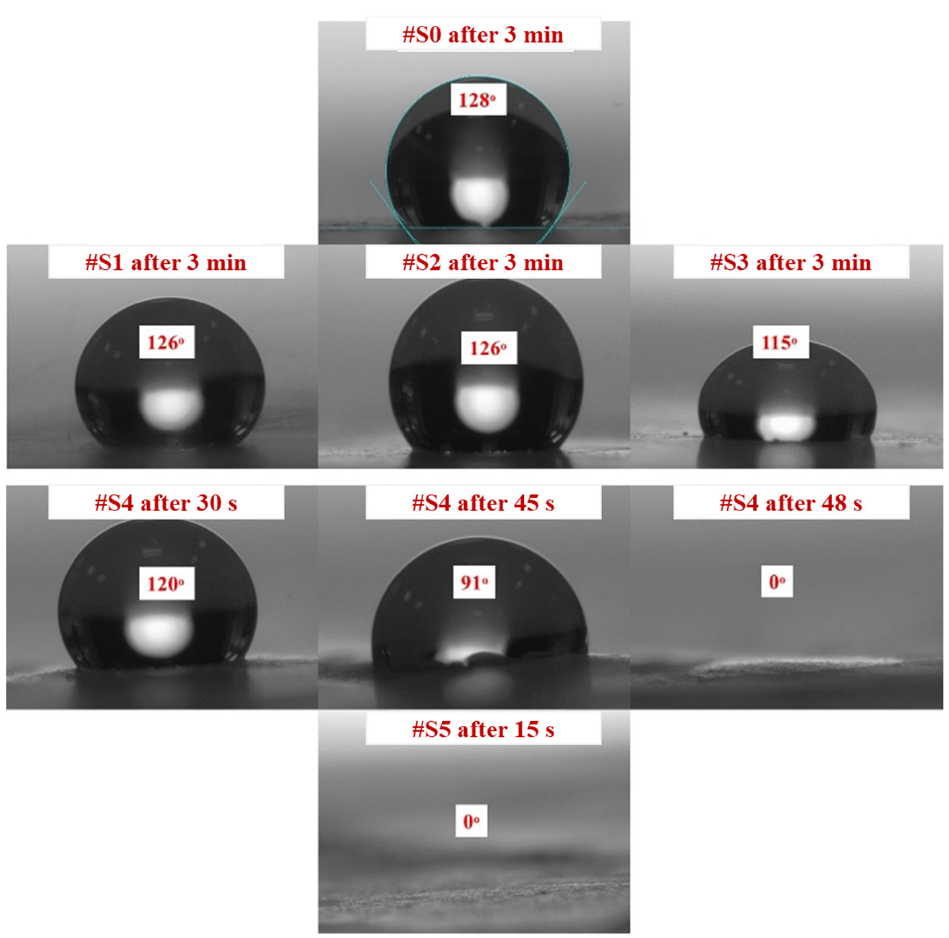
Figure 4. Contact angles of #S0; #S1, #S2, and #S3 after 3 min; #S4 after 30, 45, and 48 s; and #S5 after 15 s.